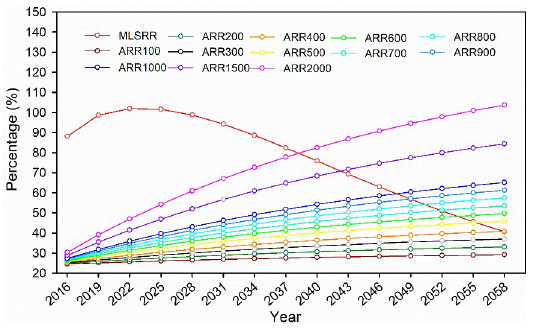
Fig 2. Comparison of actual replacement rate (ARR) and modified living standards replacement rate (MLSRR) of the insured residents aged below 60 (the middle aged and young people) when they join the New Rural Pension Scheme. The ARR100, ARR200, ... , and ARR2000 indicate the predicted ARR when selecting the payment levels of ¥100, ¥200, ... , and ¥2,000 per